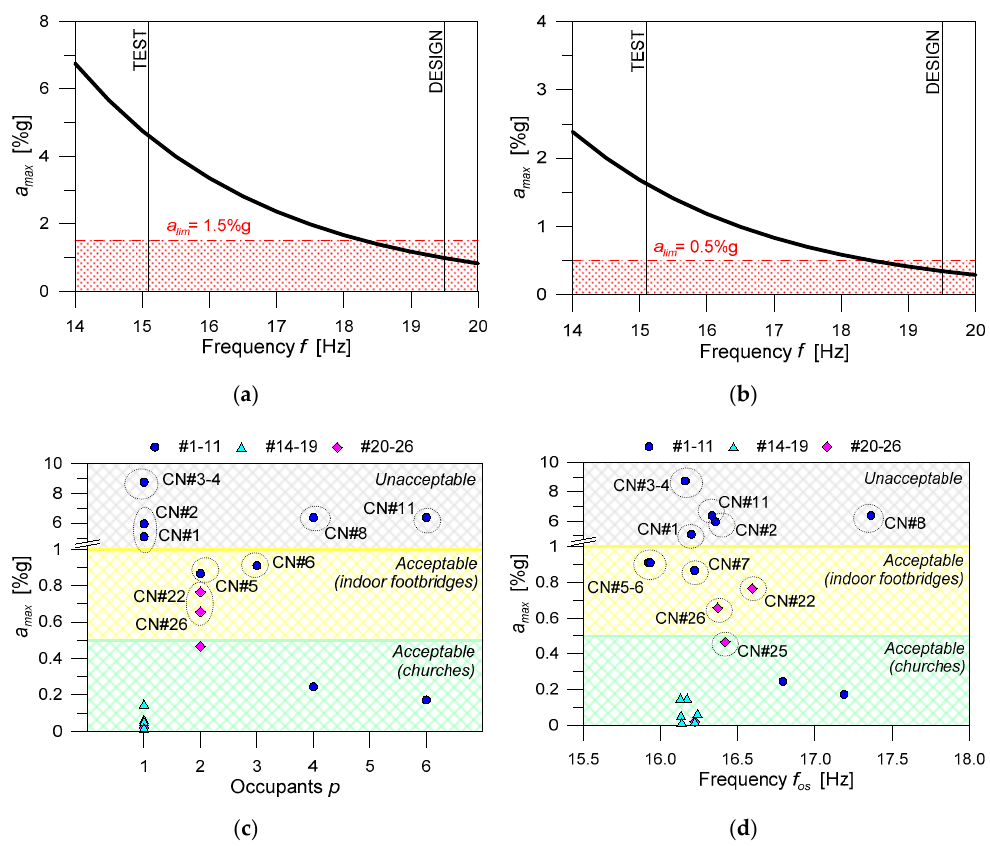
Figure 13. Vibration serviceability assessment of the examined system, based on the AISC technical guide. Expected acceleration peaks, based on Equation (10), for ( a ) indoor footbridges and ( b ) church systems, with ( c , d ) assessment of experimental acceleration peaks (average values, vertical direction), as a function of the number of occupants or frequency.